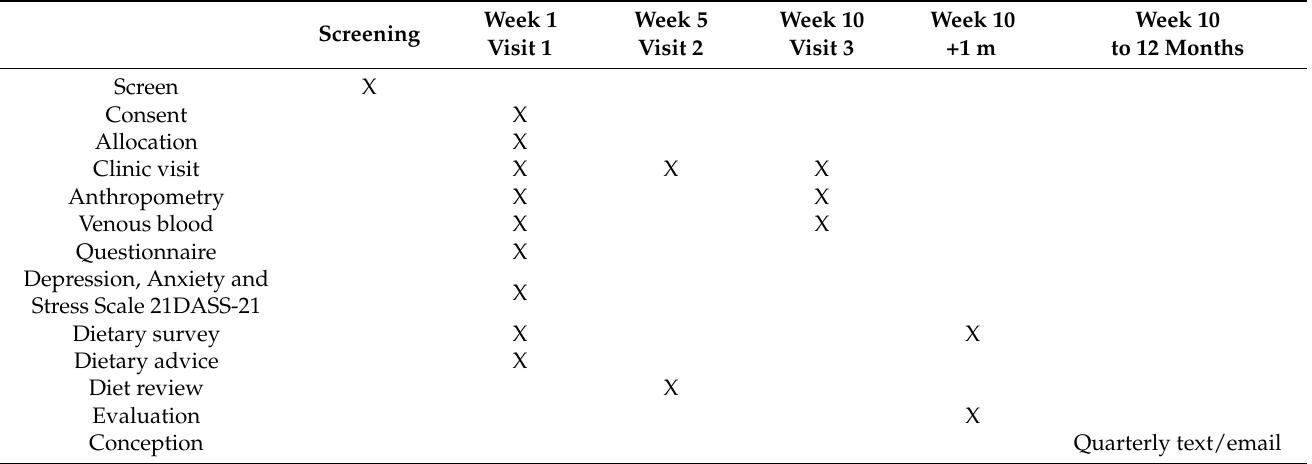
Table 1. Protocol and Data Collection